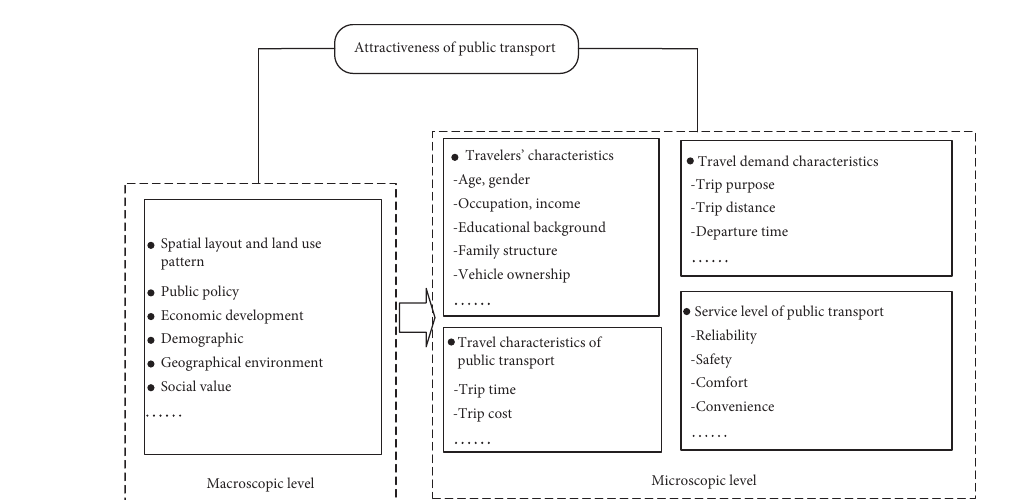
Figure 6: Factors affecting the attractiveness of public transport and their